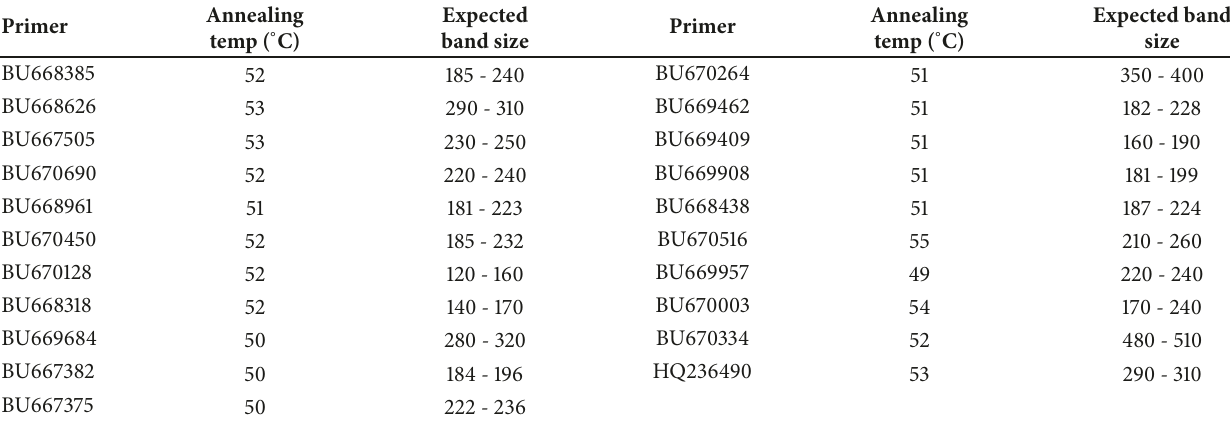
Table 2: List of 21 SSR primers used for the